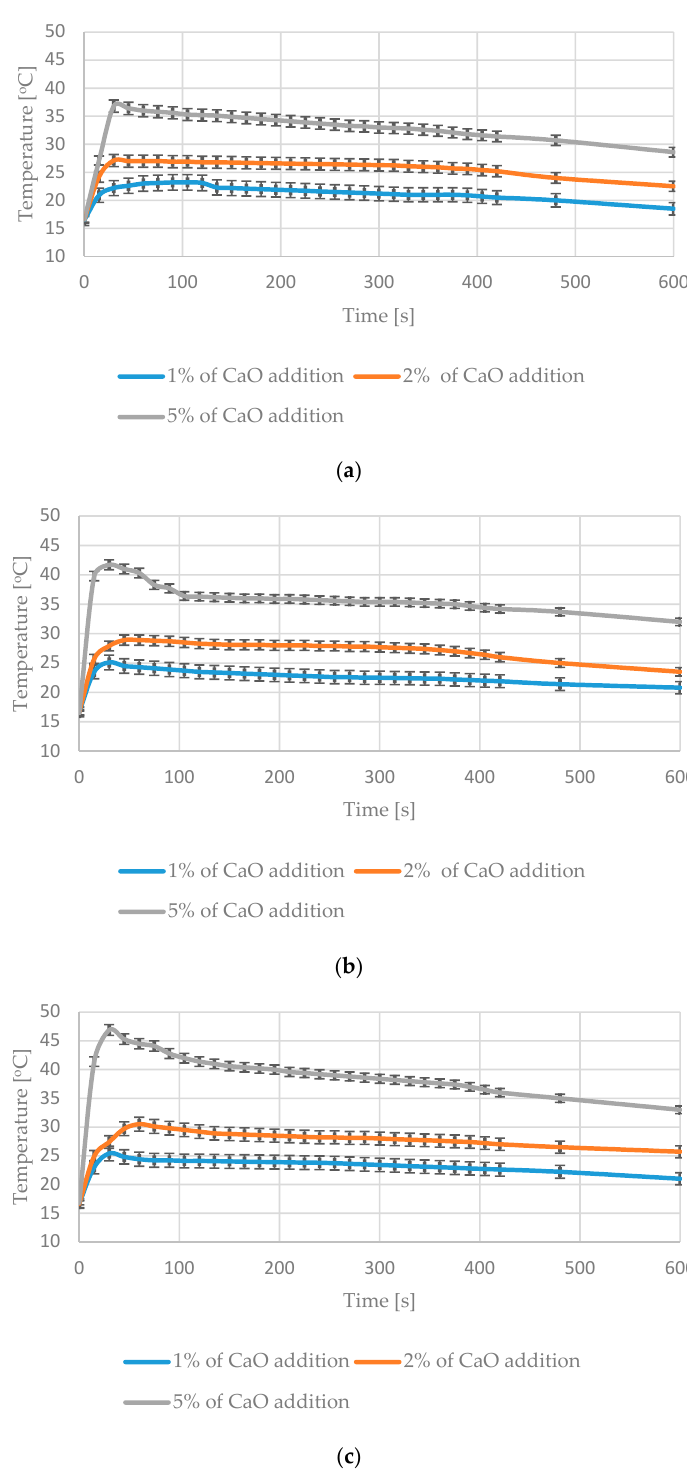
Figure 5. Temperature changes during mixing of materials: ( a ) UFMSW with 35% moisture content and different mass additions of CaO, ( b ) UFMSW with 50% moisture content and different mass additions of CaO, ( c ) UFMSW with 60% moisture content and different mass additions of CaO. Adding CaO to RDF caused the temperature increase of materials placed in the mixer. The increase was visibly higher in the case of RDF (with 30% moisture content). For the 5% CaO addition to